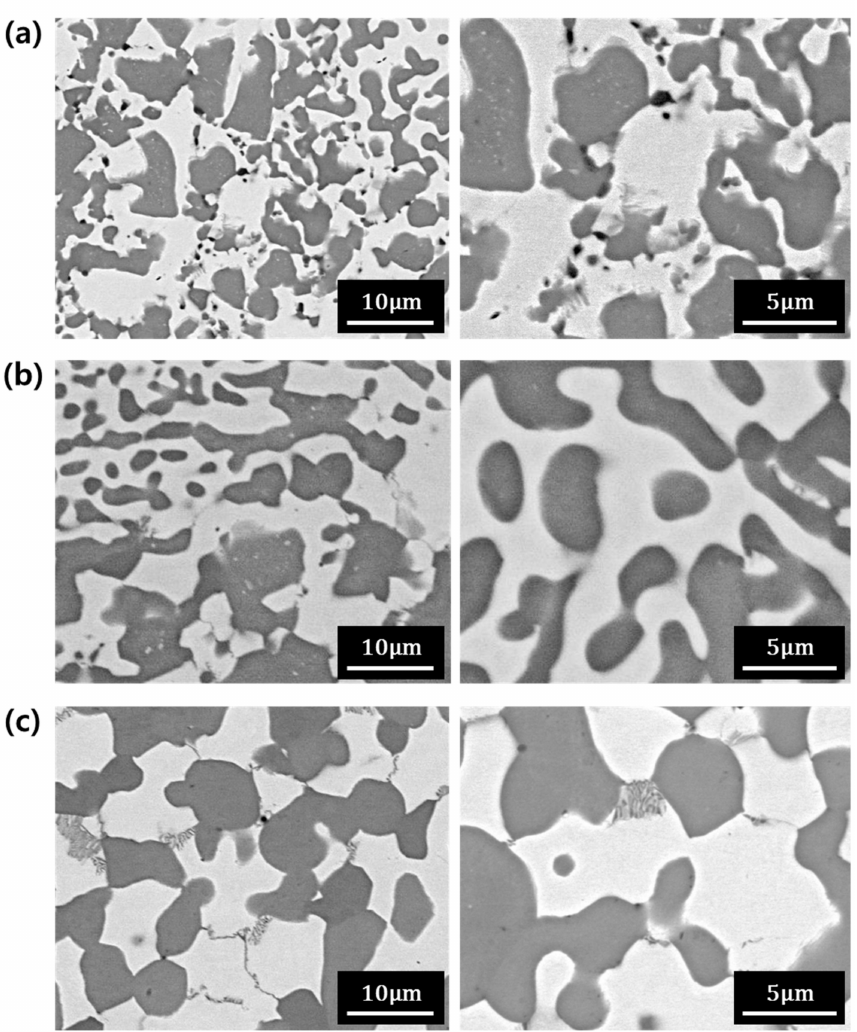
Figure 4. ( a ) Microstructure of the compacts sintered at ( a ) 1500, ( b ) 1600, and ( c ) 1700 ◦ C as observed via backscattered electron